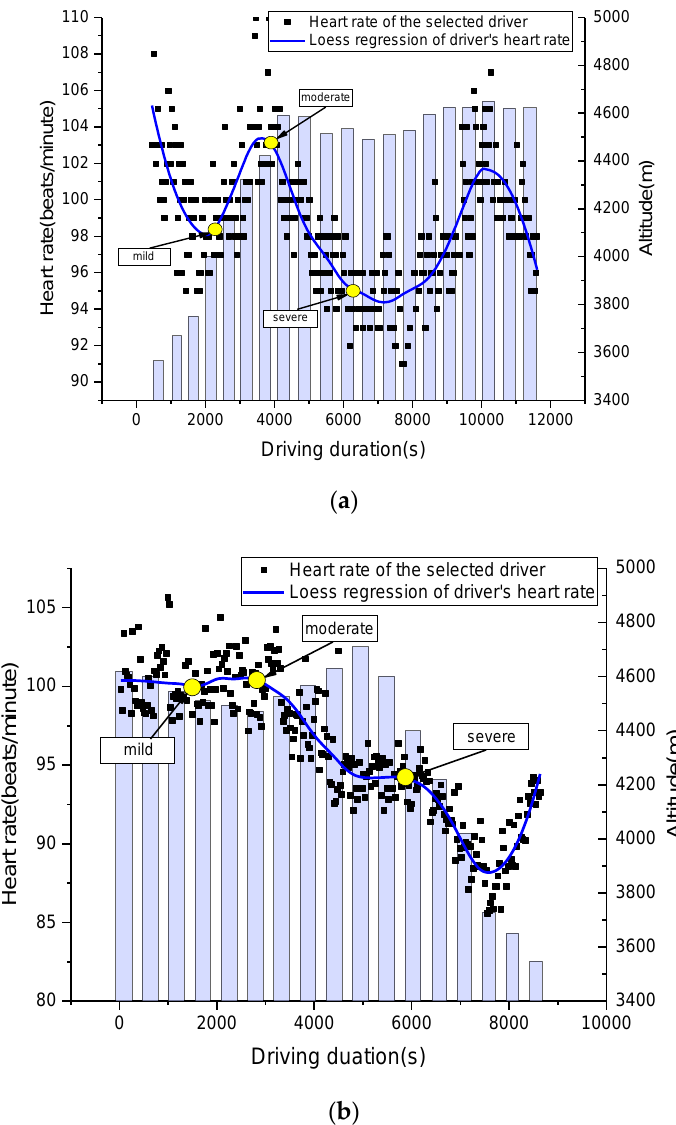
Figure 5. Variations in heart rate with altitude and driving duration. ( a ) Upslope trip and ( b ) downslope trip.